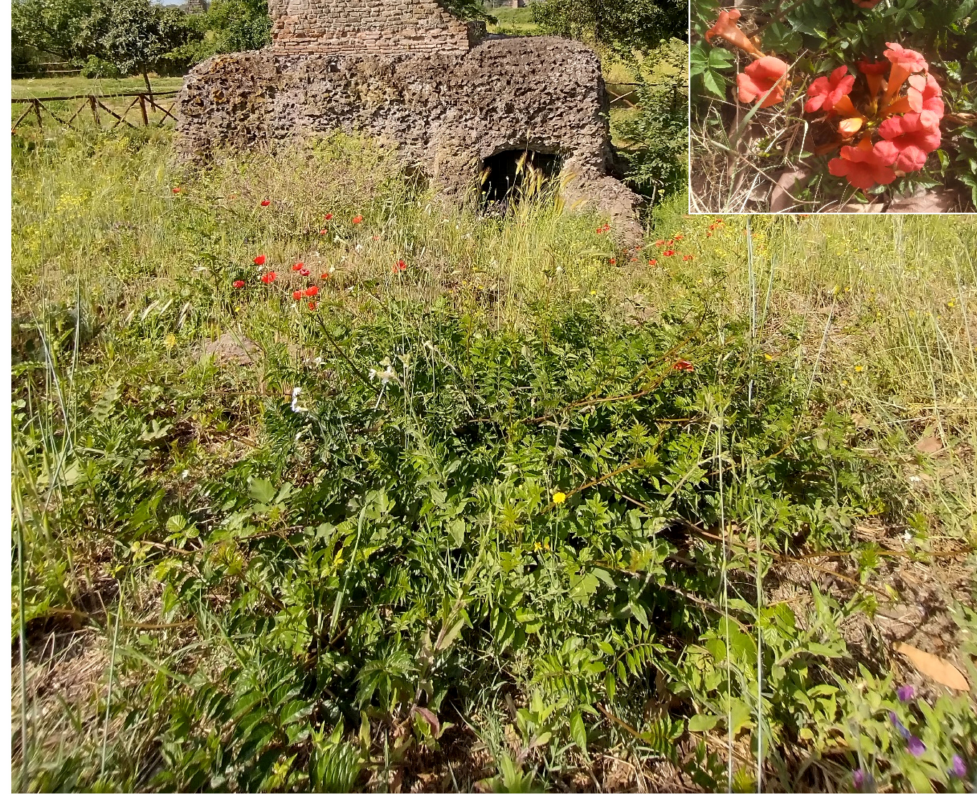
Figure 51. Campsis radicans in Acquedotti